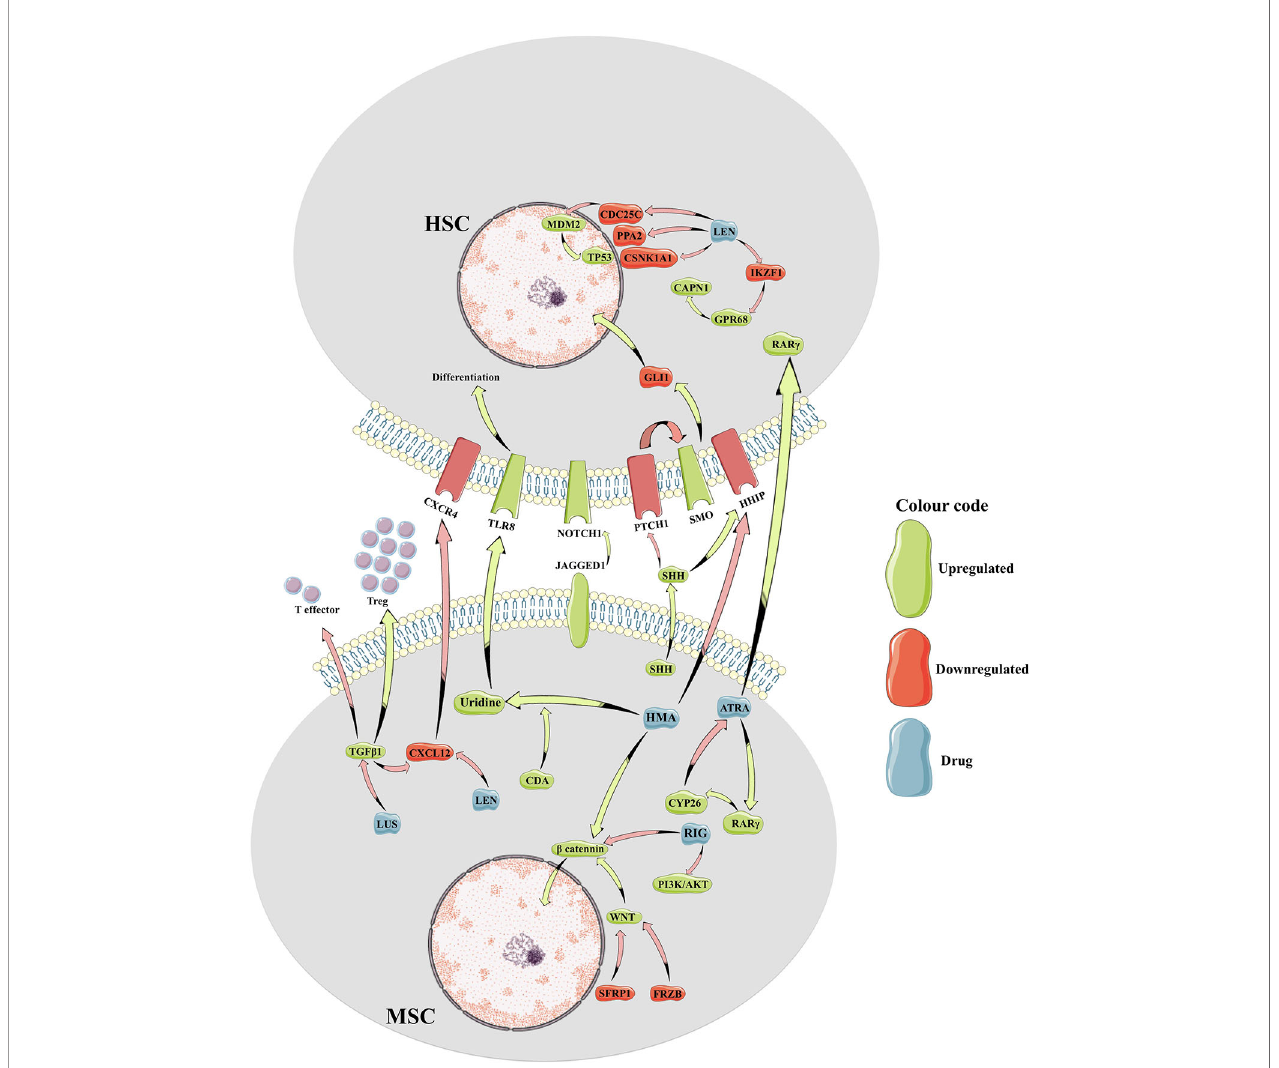
FIGURE 1 | Cartoon representation of molecular crosstalk between mesenchymal bone marrow microenvironment and the myelodysplastic hematopoietic cells. HSC, hematopoietic stem cell; MSC, mesenchymal stem cell; Treg, T regulatory cells; HMA, hypomethylating agents; LEN, lenalidomide; LUS, luspatercept; RIG, rigosertib; ATRA, all-trans retinoic acid; CAPN1, calcium-dependent protease calpain1; CDA, cytidine deaminase; CDC25C, Cell Division Cycle 25C gene; CSNK1A1, casein-kinase 1A1; GPR68, G Protein-Coupled Receptor 68 gene; IKZF1, IKAROS Family Zinc Finger 1 gene; PI3K, Phosphatidylinositol-3 Kinase; PPA2, Inorganic Pyrophosphatase gene; RAR g , Retinoic Acid Receptor Gamma; SHH, Sonic Hedgehog ligand; TGF b , transforming growth factor beta; TLR8, Toll-Like Receptor